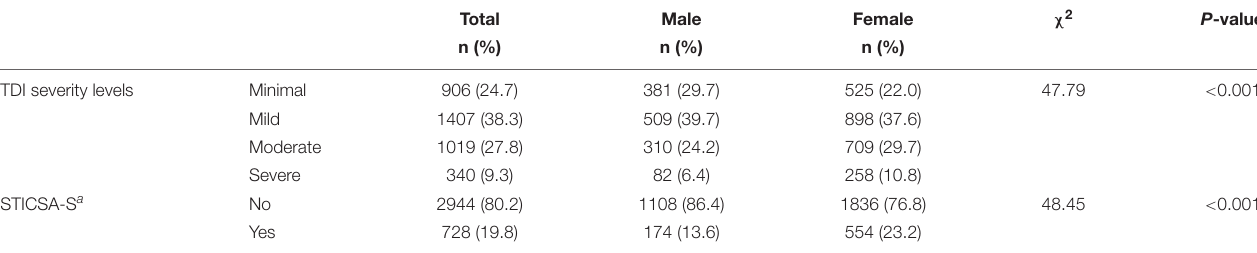
TABLE 2 | Prevalence of depressive severity levels, and state anxiety during the COVID-19 outbreak in the Italian population stratified by sex ( N = 3,672). Total Male Female χ 2 P -value n (%)